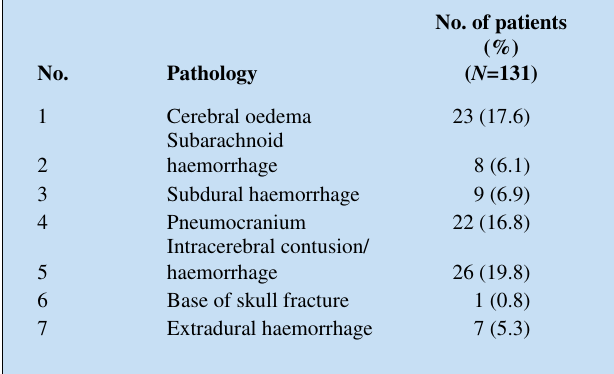
Table II. Pathology groups observed on CT scan